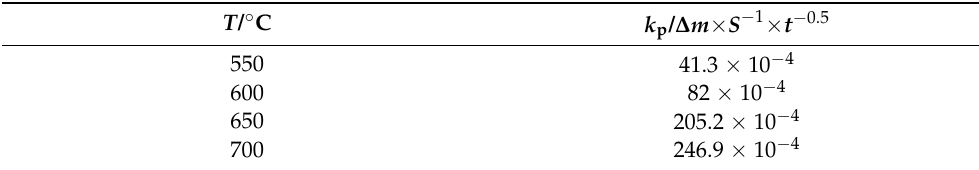
Table 1. Values of the constant of the mass gain rate ( k p ) of Mg coated samples for 550, 600, 650, 700 ◦ C.